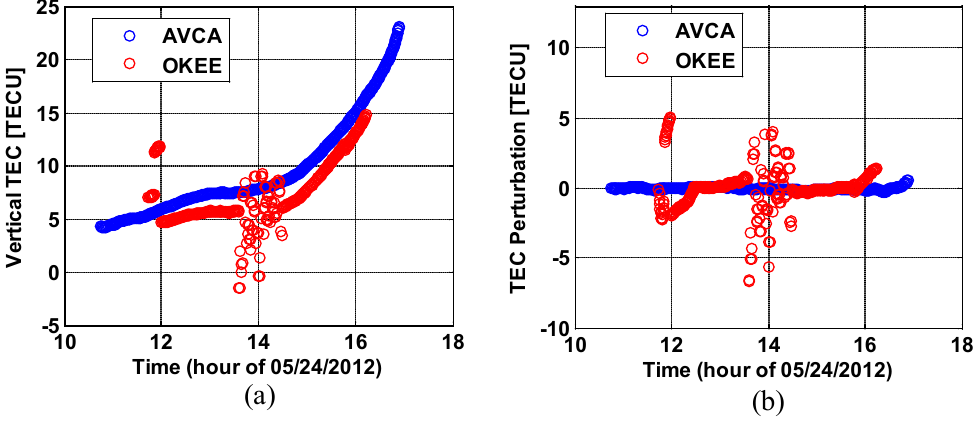
Figure 3. VTEC and VTEC perturbations corrupted by poor quality GNSS data: ( a ) dual-frequency vertical TEC estimates and ( b ) VTEC perturbations for CORS stations OKEE (poor quality data) and AVCA (good quality data).